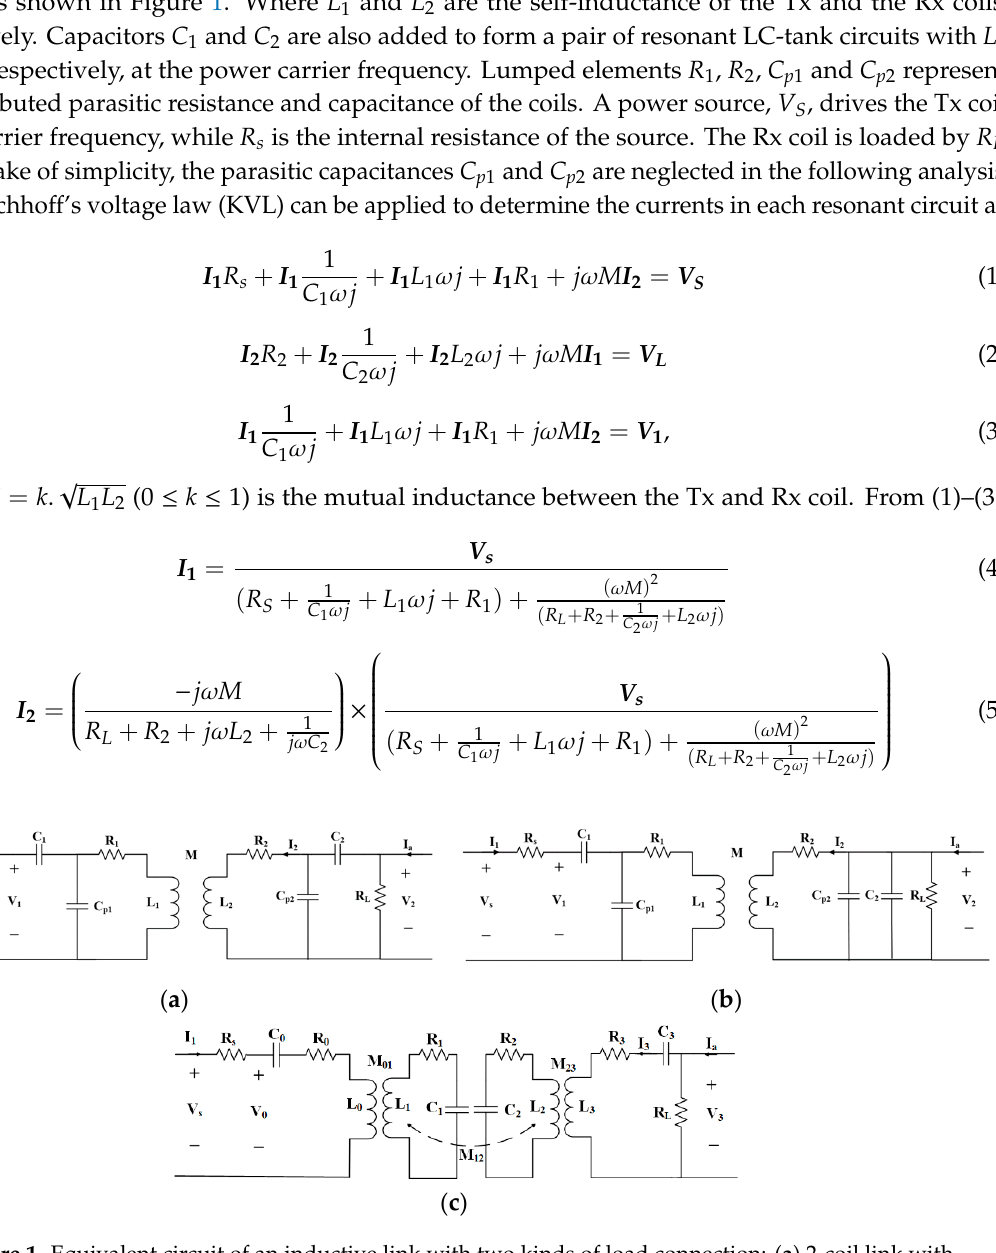
Figure 1. Equivalent circuit of an inductive link with two kinds of load connection: ( a ) 2-coil link with series connection; ( b ) 2-coil with parallel connection; ( c ) 4-coil with series